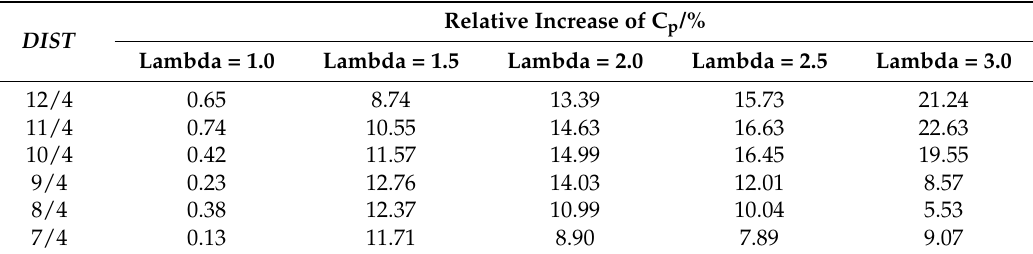
Figure 17. Power output efficient of twin-rotors system at different tip speed ratio and different axis distances. Table 2. Relative increase of power output efficiency.